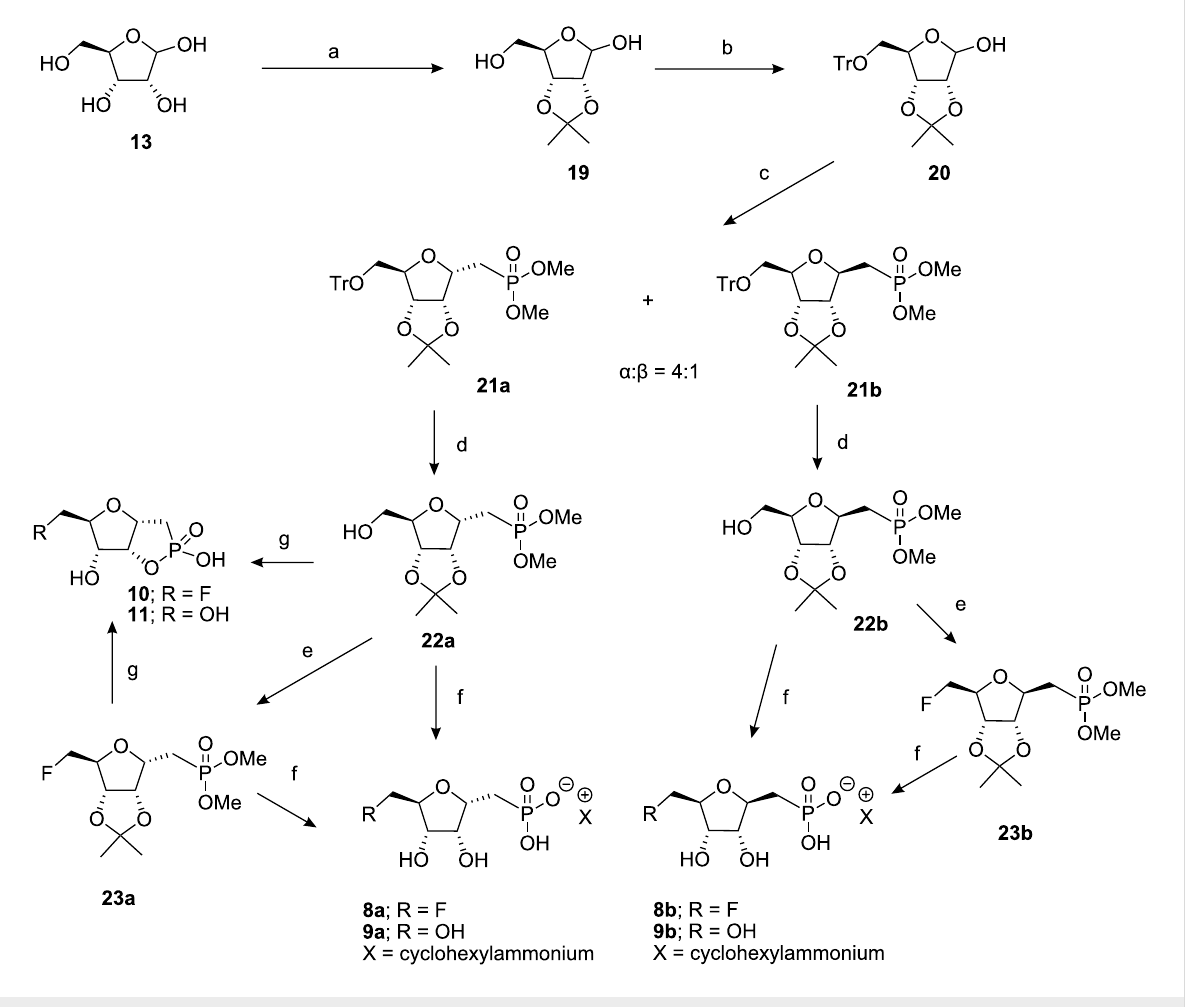
Scheme 3: Synthetic route B. Reagents and conditions: a) acetone, concd H 2 SO 4 (cat.), 4 h, 90%; b) TrCl, pyridine, DMAP, rt, 16 h, 94%; c)